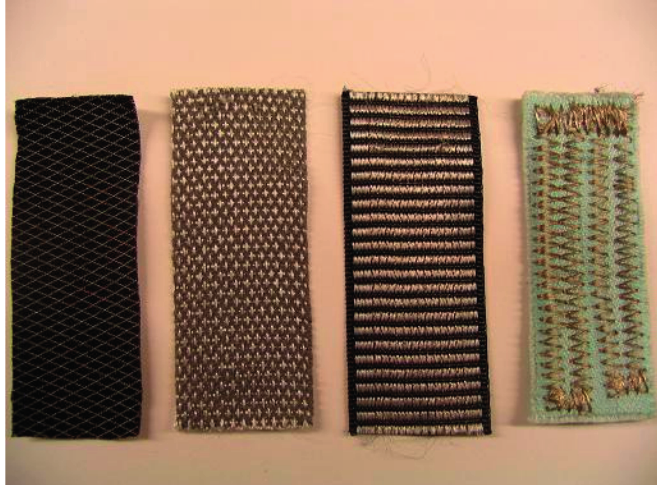
Figure 16. Four textile electrodes with different structures and materials [29]. Copyright © 2007